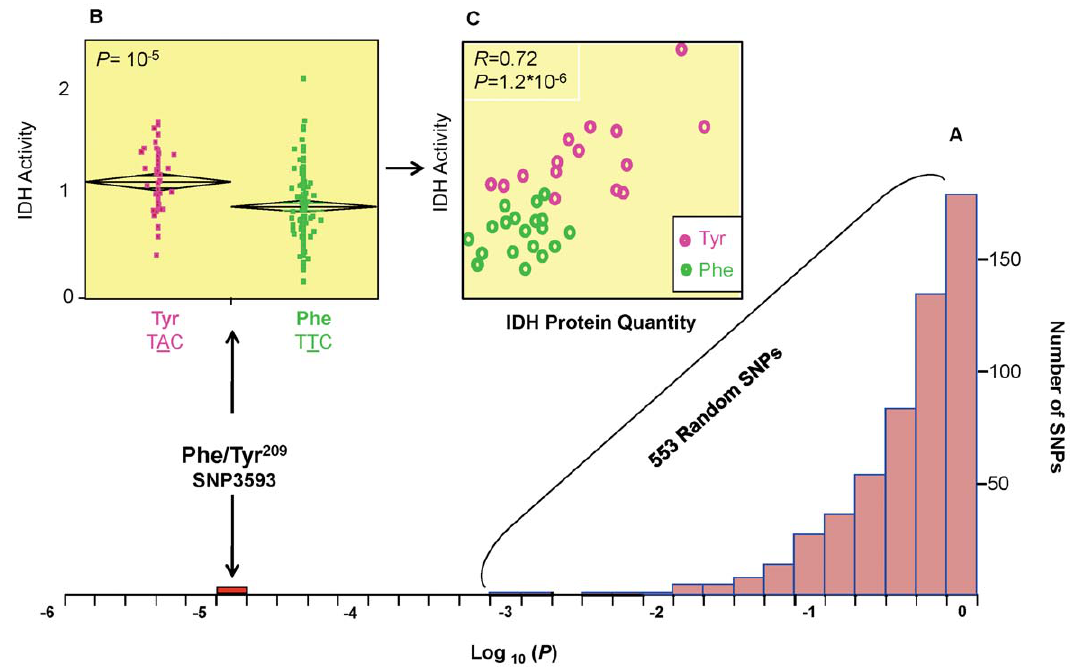
Figure 2. Effect of Phe/Tyr 209 on IDH enzyme activity and protein quantity. ( A ) Frequency distribution of association tests P -values for 553 random SNP (pink bars) and idh SNP3593 (red bar). On the X axis are the log 10 ( P ) values for association tests using mixed-linear model. ( B ) Comparison between the two alleles at SNP3593 for IDH activity. A combined standardized IDH activity data from the two incubation temperatures is presented. ( C ) Correlation between IDH total activity and IDH protein quantity across a subset of 35 lines. Each point represents the mean of 3 biological replications.